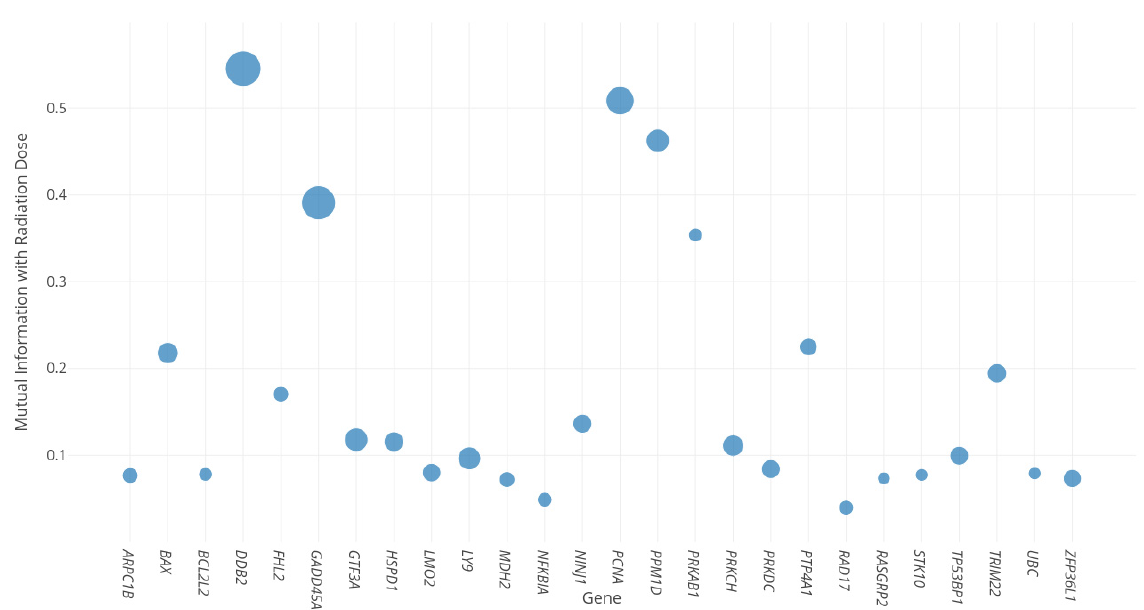
Figure 7. Scatter plot depicting the mutual information each gene’s expression shares with radiation exposure (averaged over GSE10640[GPL6522], GSE6874[GPL4782], and GSE1725). The size of each circle is proportional to the frequency at which the gene appears in the top 20 human signatures ranked by average validation log loss from GSE10640[GPL6522], GSE6874[GPL4782], and GSE1725. The genes shown are also are the same as those indicated in Figure 6.